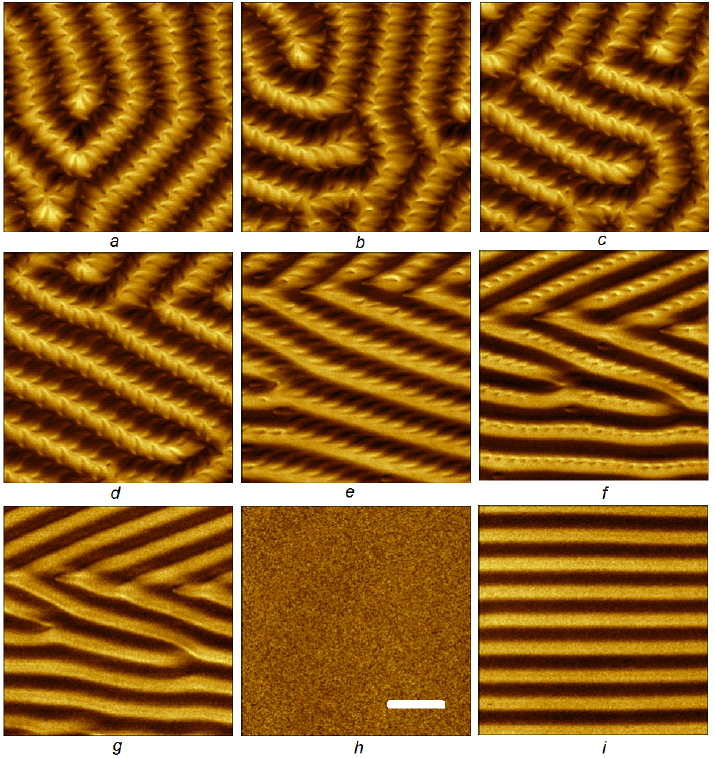
Figure 1. A series of MFM images of the garnet film in the in-plane magnetic field. The field is directed along the X axis; the film was initially in the demagnetized state. ( a ) H = 0 Oe, ( b ) H = 35 Oe, ( c ) H = 40 Oe, ( d ) H = 65 Oe, ( e ) H = 205 Oe, ( f ) H = 260 Oe, ( g ) H = 370 Oe, ( h ) H = 470 Oe, ( i ) H = 370 Oe. The scale bar corresponds to 5 µ